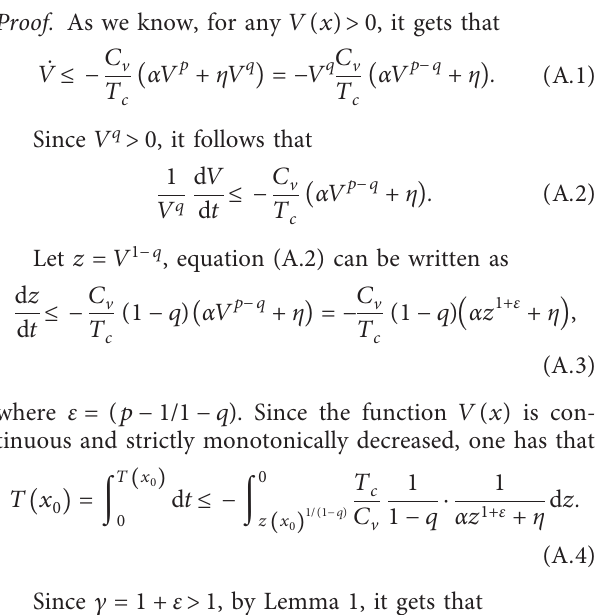
Figure 6: Synchronization error for several different initial con- ditions with the predefined-time T c � 0 . 06.